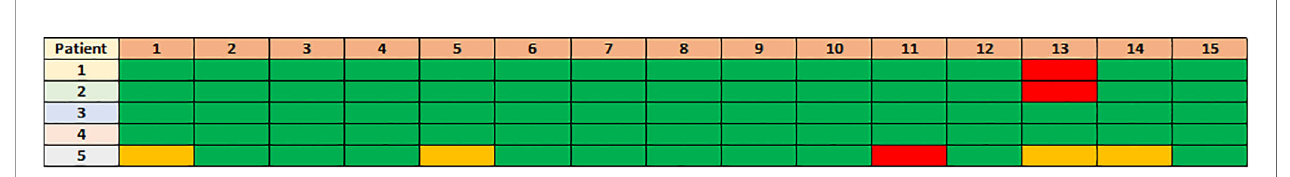
FIGURE 2 | Visual representation of the treatment fractions analyzed for each patient. The optimal fractions are in green, the non-optimal but acceptable fractions are in yellow, and the fractions requiring online adaptation are